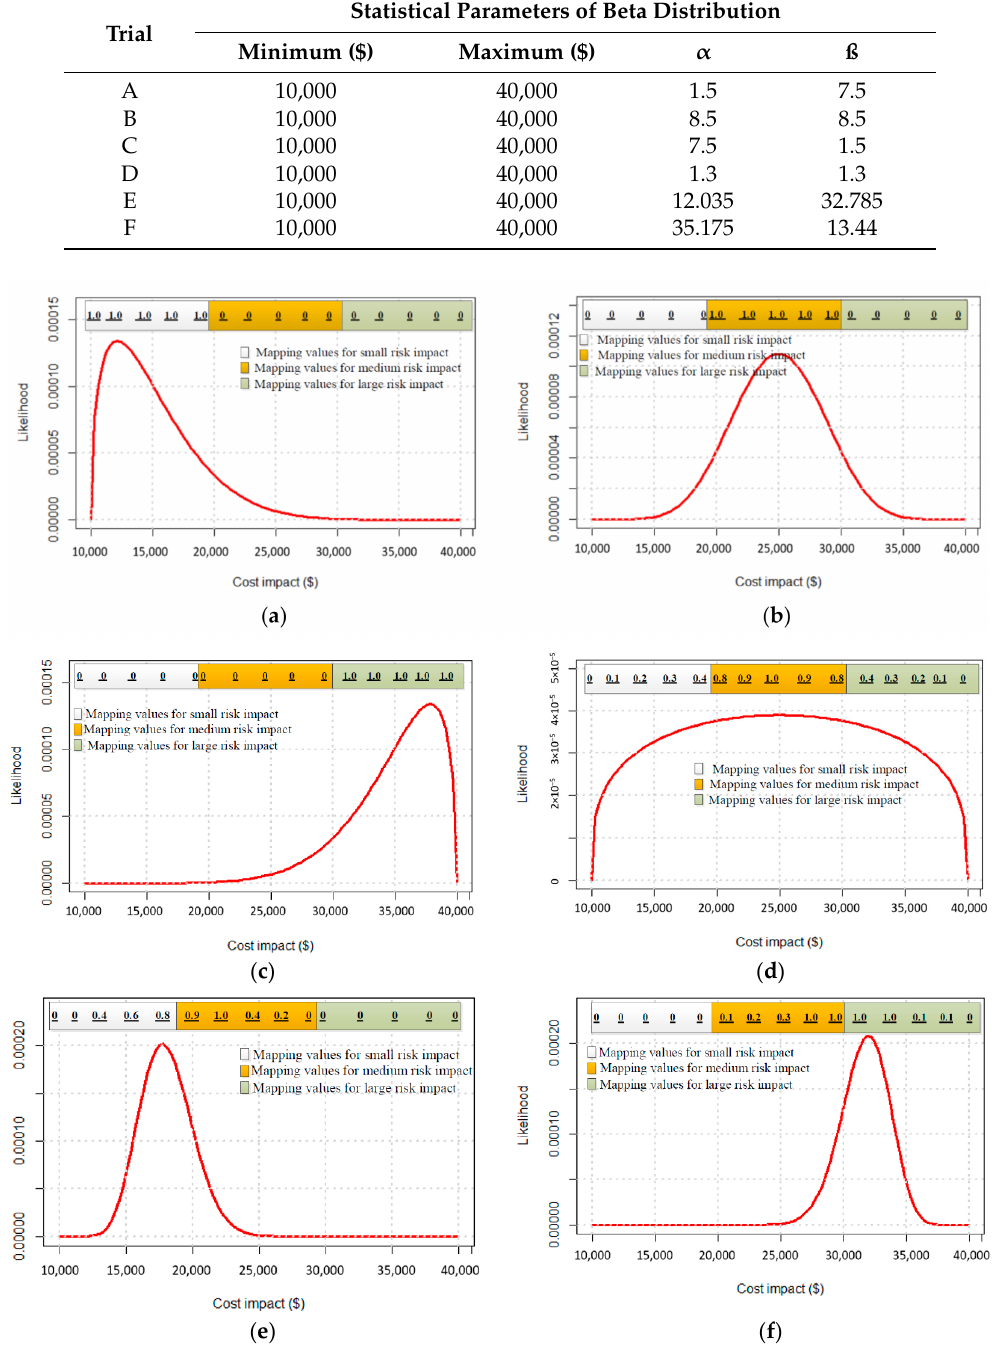
Figure 11. Marginal Beta distributions after changing the mapping value of the risk impact range in ( a ) Trial A, ( b ) Trial B, ( c ) Trial C, ( d ) Trial D, ( e ) Trial E, and ( f ) Trial